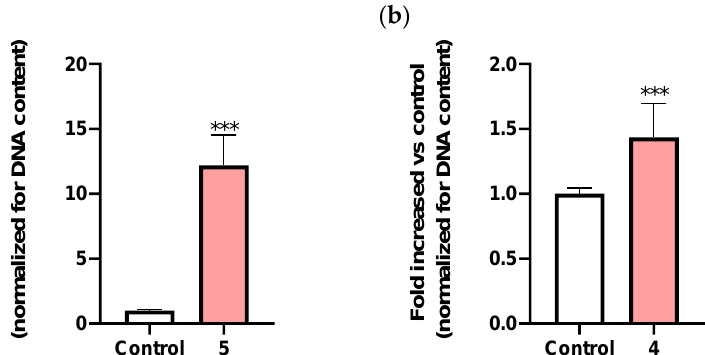
Figure 3. Effect of the compounds 5 and 4 at 100 µ M on the activity of caspase-3, on ( a ) AGS cell line and ( b ) A549 cell line. The results correspond to the mean of each well of four independent experiments performed in duplicate. The values were normalized for DNA content. *** p < 0.001.